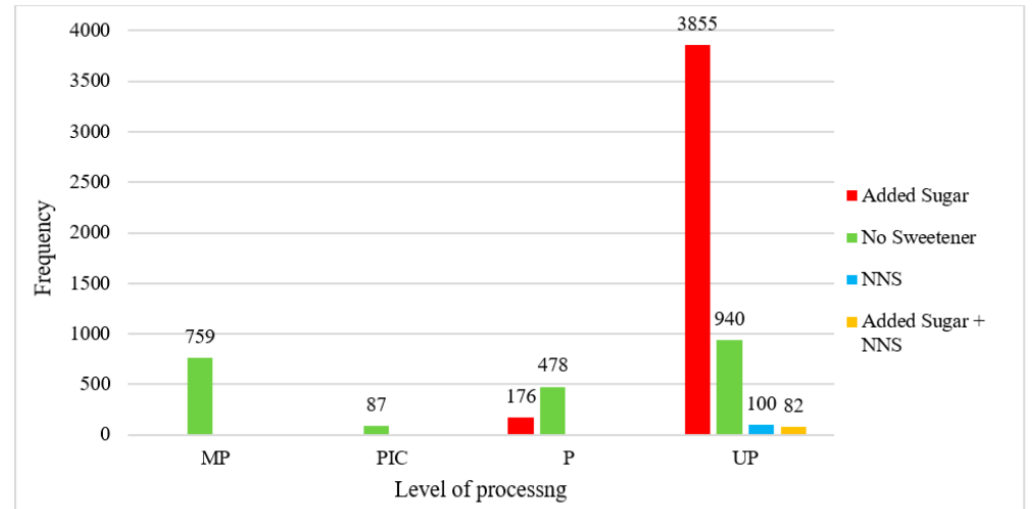
Figure 3. Frequency of sweetened HSR products by NOVA category. MP—Minimally processed; PCI—processed culinary ingredients; P—Processed;